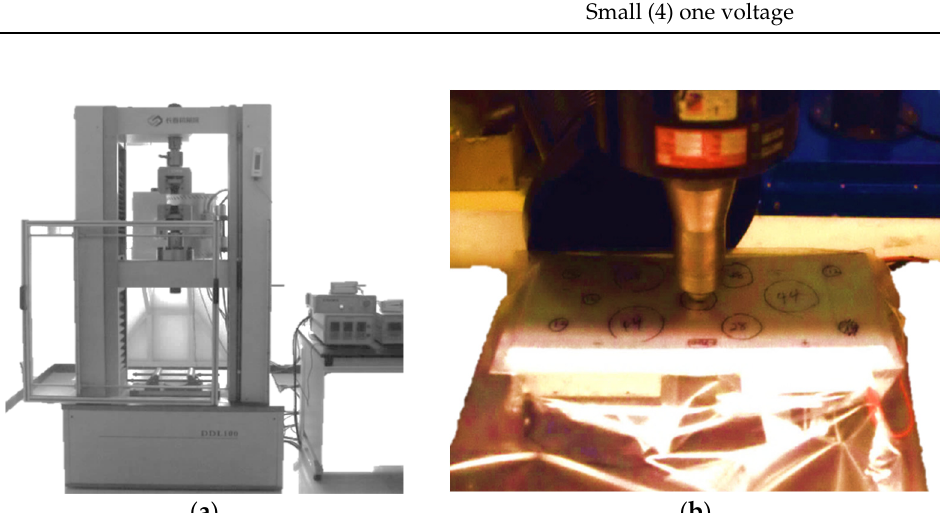
Figure 4. ( a ) Punching on the cell during the test (number of punches with different size were used) ( b ) Universal testing machine > 50 kN. Table 2. Number of tests on each cell. Cell No.